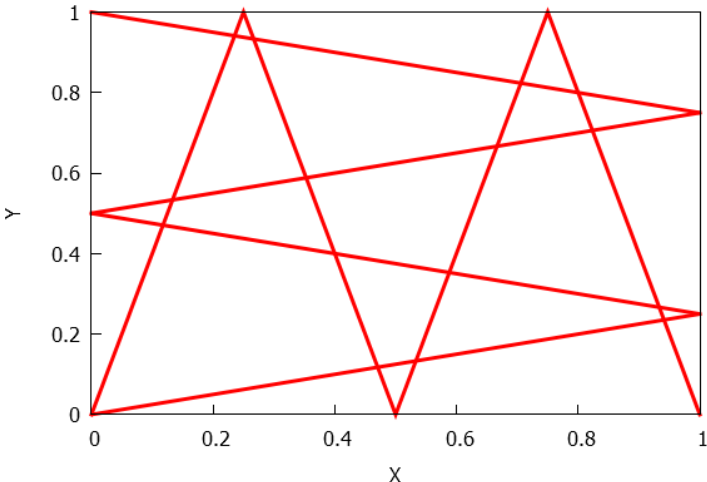
Figure 28. The graphs Γ f and Γ ∗